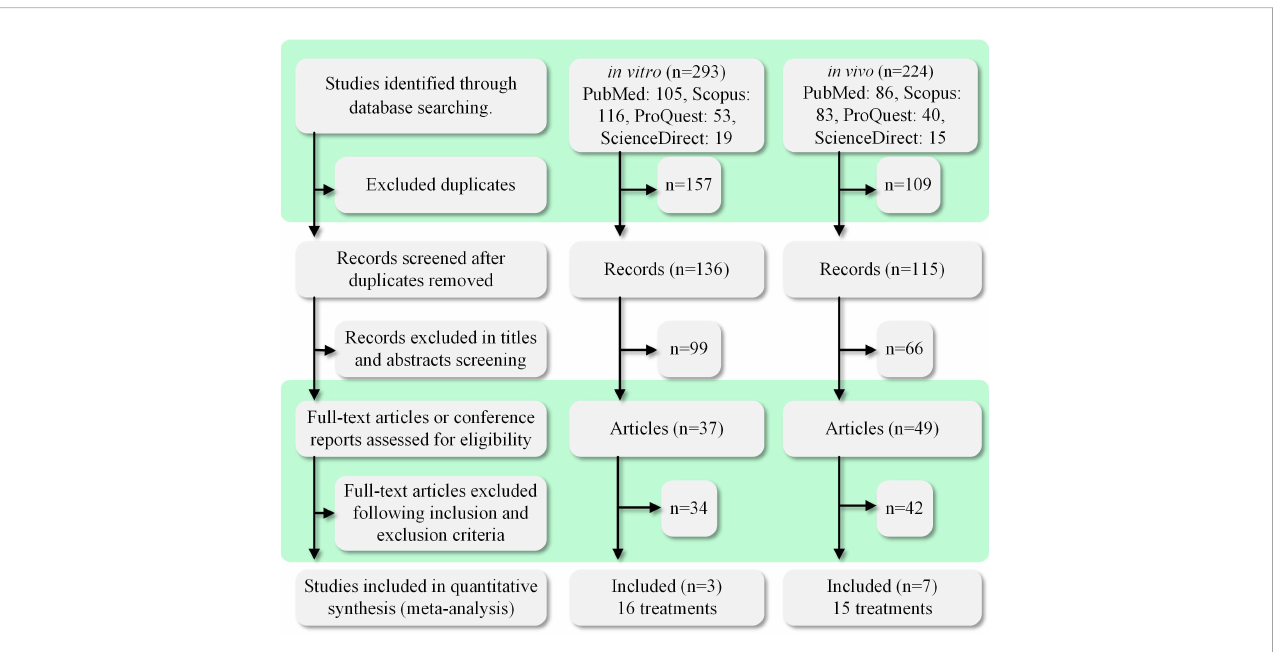
FIGURE 1 PRISMA diagram of the study selection process. The search time range was the past 30 years (1992 – 2022). We searched four databases: PubMed, ProQuest, ScienceDirect, and Scopus. A total of 517 relevant studies were found. The studies were divided into in vivo and in vitro categories for searching and screening. A total of 10 studies were selected for inclusion in this meta-analysis